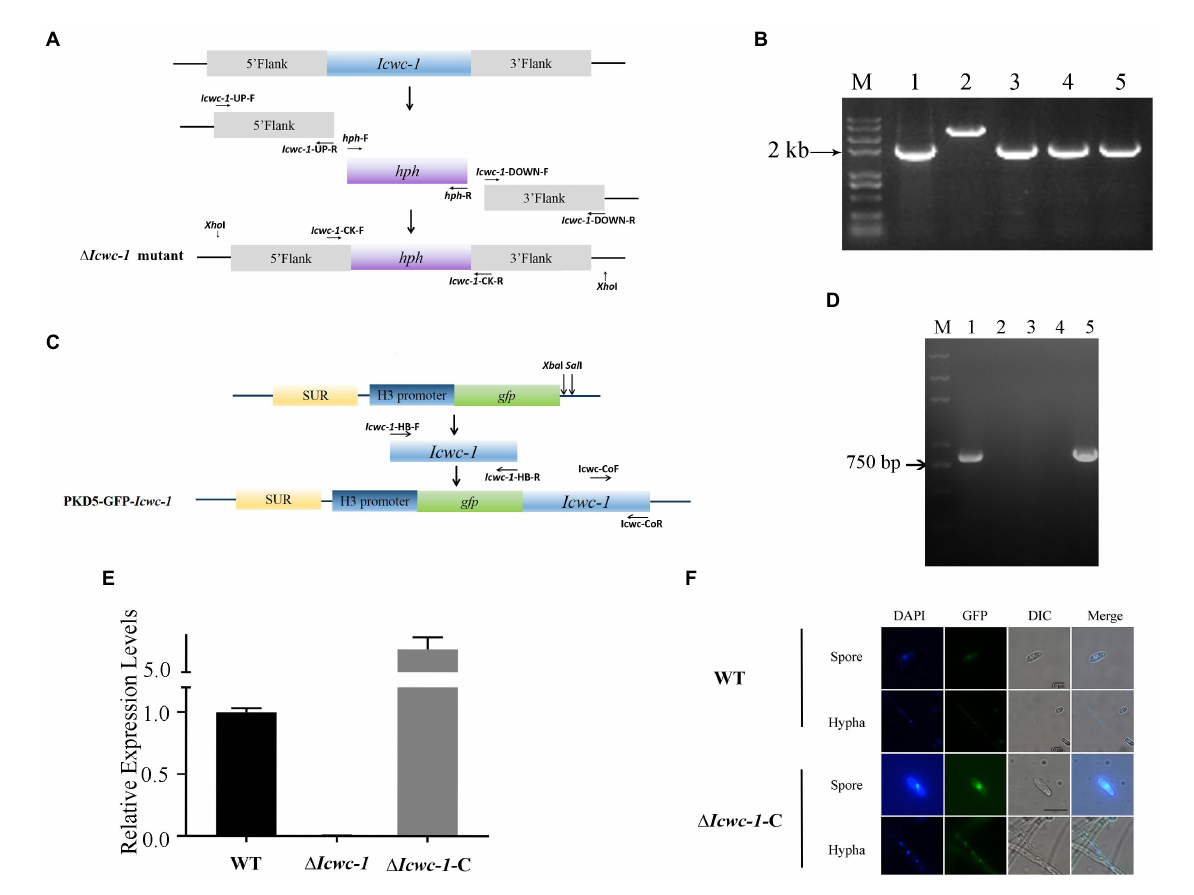
FIGURE 2 Generation and identification Icwc-1 mutants of I. cicadae . (A) Schematic diagram of knockout ∆ Icwc-1 via homologous recombination. (B) PCR validation of knockout strains. M: Maker, 1: knockout vector PCAMBIA1300- Icwc-1 , 2: WT strain, 3–5: mutants. 3: ∆ Icwc-1- 2, 4: mutant ∆ Icwc-1- 8, 5: mutant ∆ Icwc-1- 40. (C) Schematic diagram of the generation of the complemented vector. H3 promoter in pKD5-GFP derived from Pyricularia oryzae . (D) PCR verification of complementary strains. M: Maker, 1: wild type strain WT, 2: mutant strain ∆ Icwc-1- 2, 3: mutant strain ∆ Icwc-1- 8, 4: mutant strain ∆ Icwc-1- 40, 5: the complementary strain ∆ Icwc-1- C. (E) Expression of Icwc-1 gene in wild-type strain, mutant strain, and the complementary strain. (F) Location of Icwc-1 gene expression analysis. GFP observation under fluorescence microscope. The hyphae and spores of the wild-type strain and the ∆ Icwc-1 -C strain were stained with DAPI and observed under a fluorescence microscope. Bar = 10